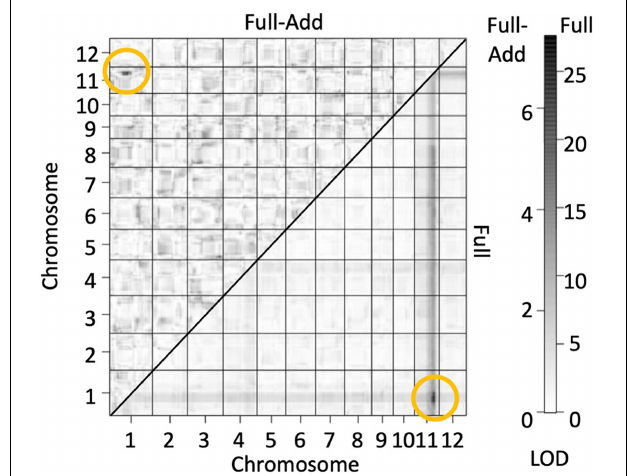
FIGURE 3 | Heat map showing quantitative trait loci (QTL) for number of panicles by assuming interaction of two loci. Bottom and upper diagonals show the LOD score of full models (LOD T ) and full-additive model (LOD Int = LOD T – LOD x – LOD y ), respectively. The yellow circles indicate sites with high LOD values and interaction between the two factors. The scale on the right shows LOD values of upper (left) and bottom (right)